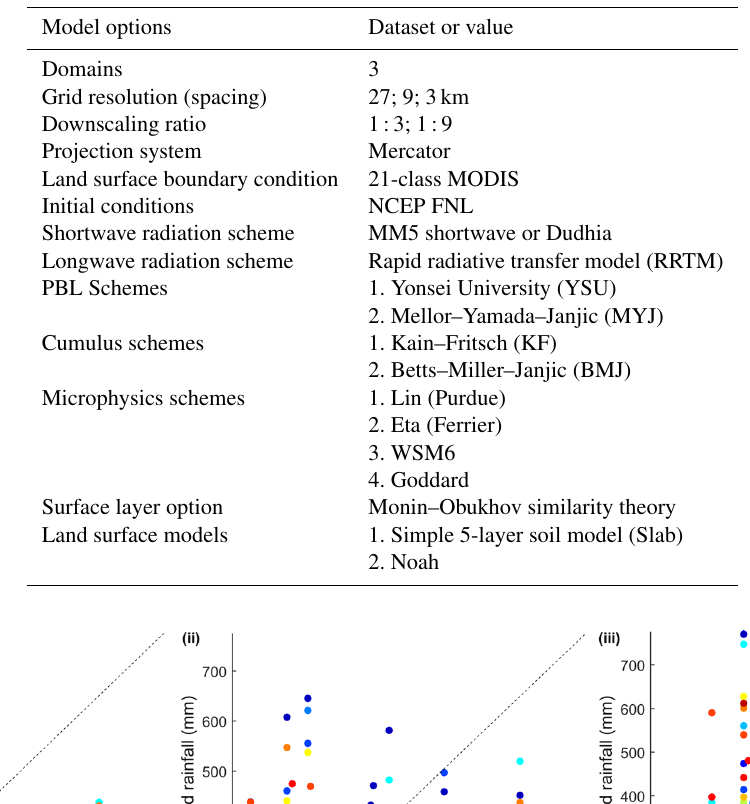
Table 3. Configuration of the WRF model considered for simulation of rainfall.